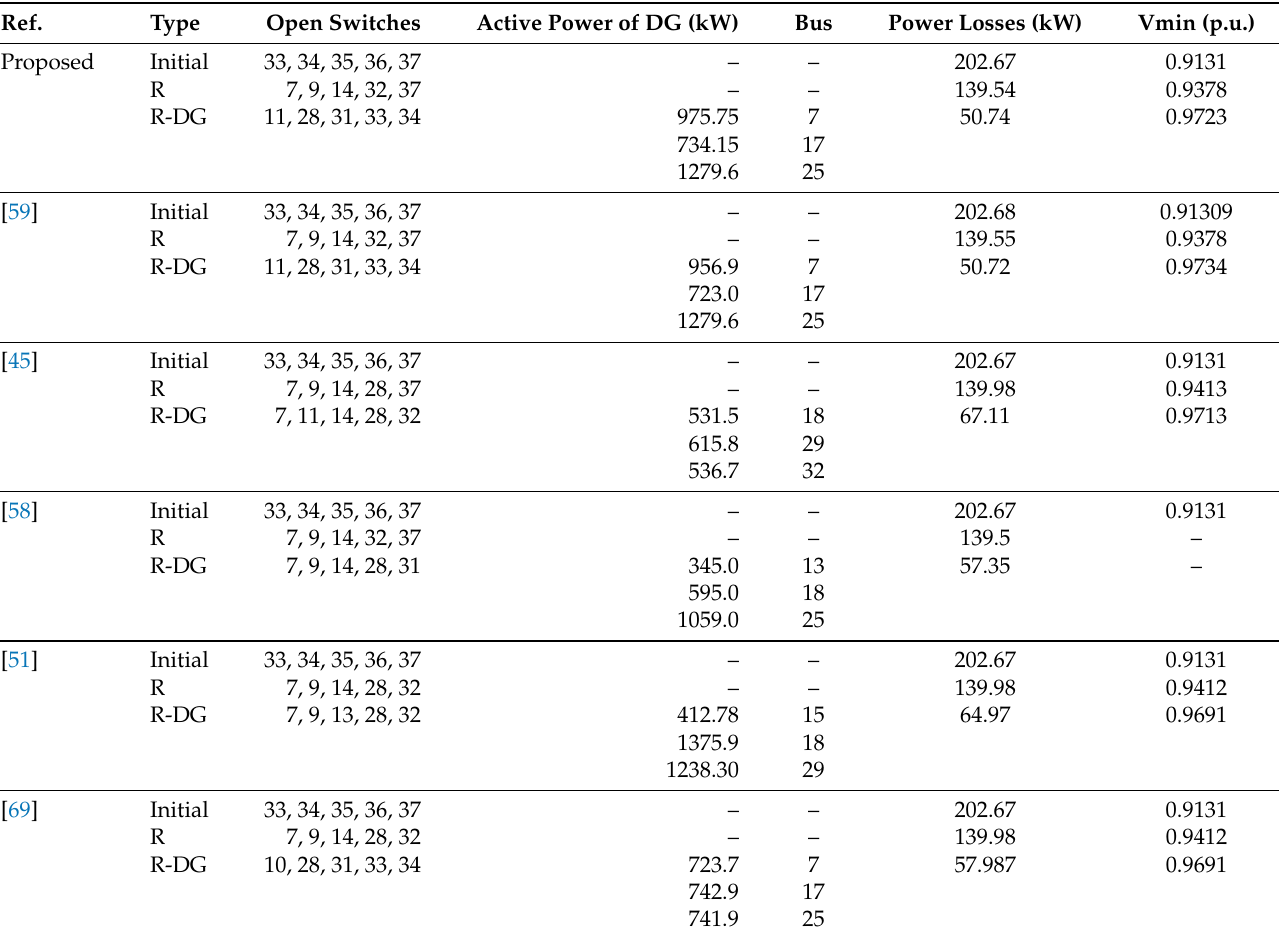
Table 9. Comparative analysis of reconfiguration with distributed generation for the 33-bus test system. Ref.